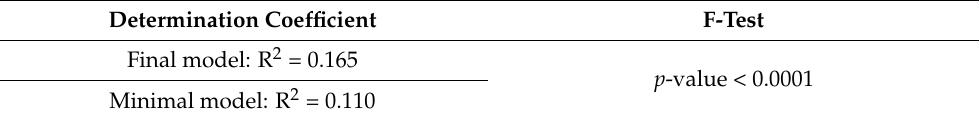
Table 7. Comparison of the final model with the minimal model containing only seasonal information.